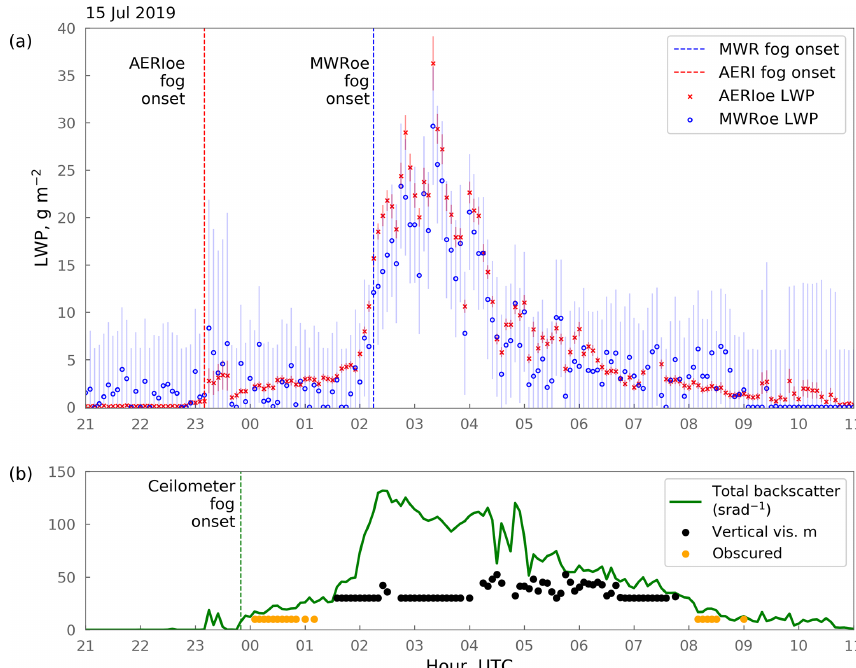
Figure 10. (a) The evolution of fog liquid water path (LWP) during the 15 July 2019 case study retrieved from the AERIoe (red) and the MWRoe (blue). Error bars show the 2 σ uncertainty of the retrievals. The vertical red line shows the fog onset determined from the AERIoe retrievals, and the vertical blue line shows the fog onset determined by the MWRoe retrievals 3h later. (b) Total range-corrected attenuated backscatter (5min mean, green line) and vertical visibility (black points) from the ceilometer. Orange points indicate when the ceilometer reports obscured.